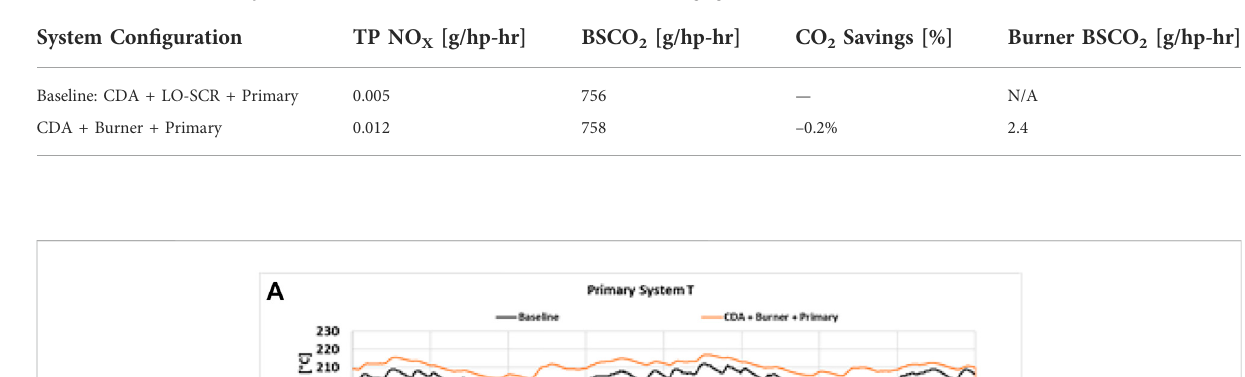
TABLE 11 BEV results comparison between Baseline and CDA + Burner + Primary system.